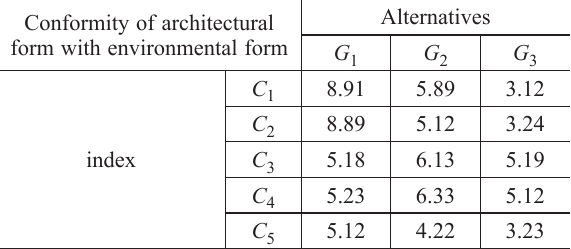
Table 15. Averages of experts’ scores for alternatives reflecting conformity of architectural form with environmental form within the major indexes